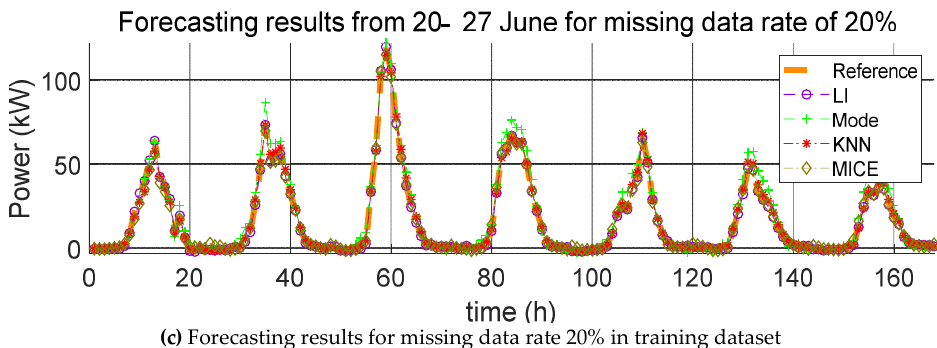
Figure 8. Forecasting results from 20 – 27 June for various missing data rates (10%, 15%, and 20%).